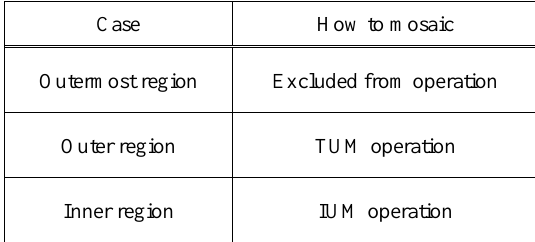
Figure 6. Detailed diagram of proposed mosaicking We tried to keep minimization of over-transformation and mismatch of the junction area between images on the mosaic image. Figure 6 is a detailed processing diagram of mosaicking.